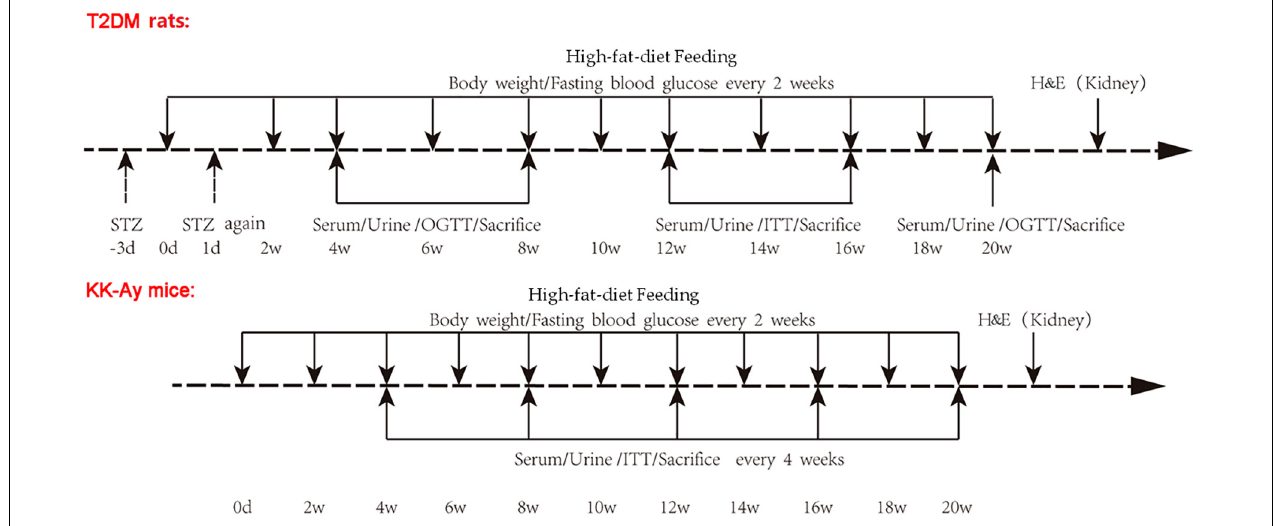
FIGURE 1 | Schematic representation of experimental design. Type 2 DM rats were induced by low dose STZ administration and high-fat-diet feeding. SD rats were randomly divided into Control rats group and T2DM rats group. After fasting for 10 h, rats in the T2DM rats group were intraperitoneally injected with 1% STZ citrate buffer at a dose of 30 mg/kg body weight in the first time ( − 3d). At 72 h after STZ injection, these rats were fasted for 3 h and subjected to measurements of FBG. The rats with FBG < 11.1 mmol/L were re-injected with the same dose of 1% STZ on the next day (1d). FBG was measured after 72 h and continued to be observed for 20 weeks. Type 2 DM rats were fed with high-fat-diet starting day 0. Rats in the Control rats group were injected with the same amount of citrate buffer, and were fed with normal diet. The KK-Ay mice model of spontaneous type 2 DM was established by feeding with high-fat-diet which was started at day 0, while the C57BL/6J control mice were fed with normal diet. The body weight and FBG for rats and mice were recorded every 2 weeks. Serum and urine samples were collected, and OGTT and ITT were performed, at the indicated time points after the initial of modeling. Animals were sacrificed at the indicated time points, and renal tissues were used for H&E staining. STZ, streptozotocin; FBG, fasting blood glucose; OGCT, oral glucose challenge test; ITT, insulin tolerance test.